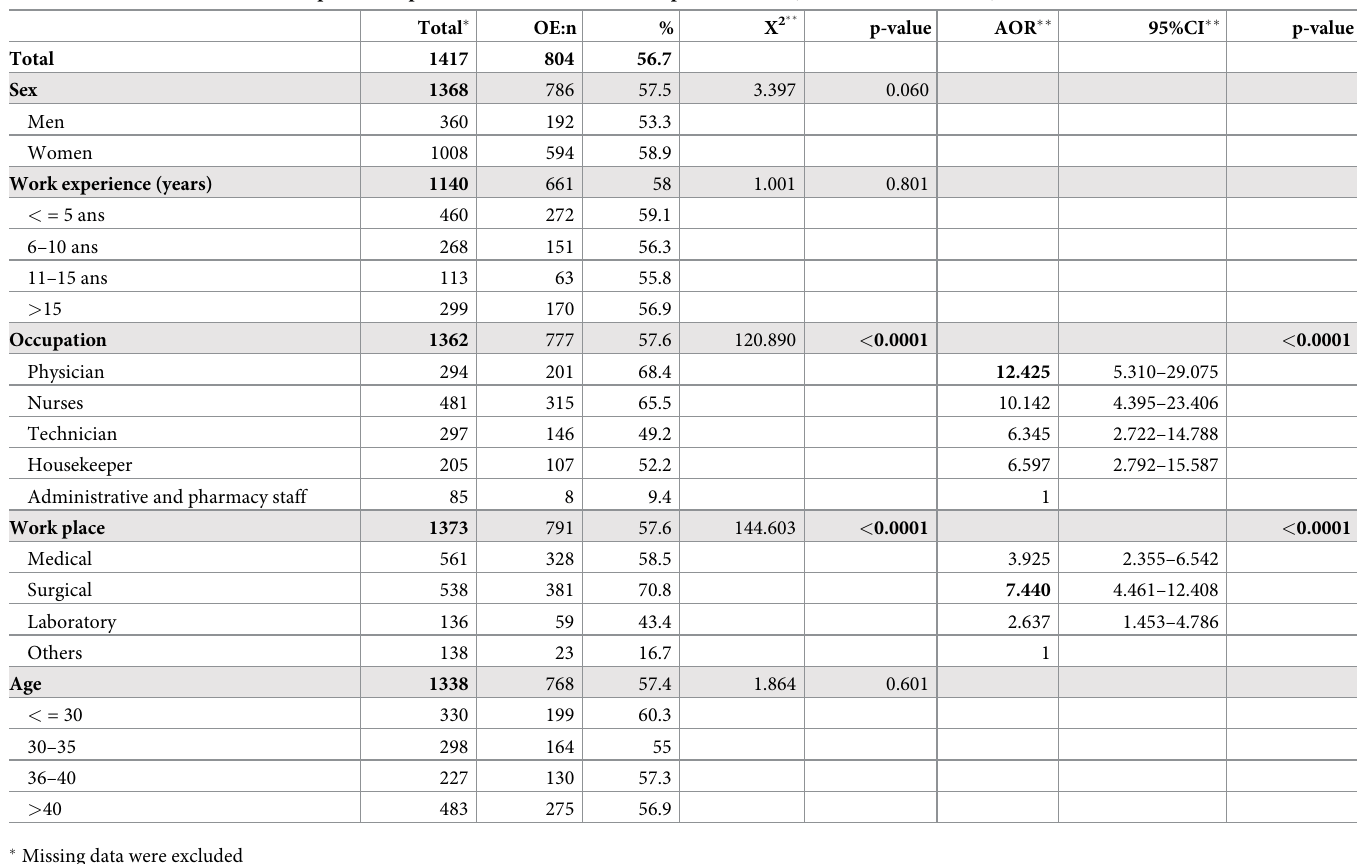
Table 3. Factors associated with occupational exposure of HCWs of FBUH to hepatitis C virus (Monastir, Tunisia